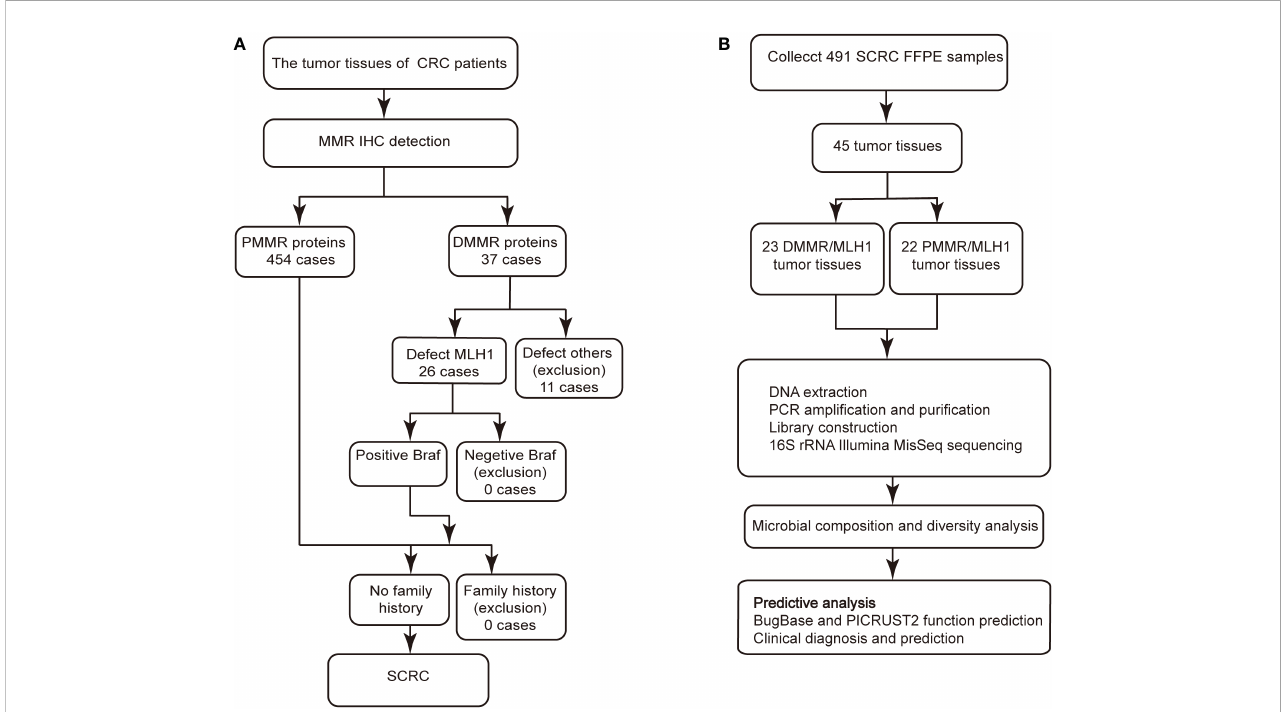
FIGURE 1 IHC staining and Gram staining were performed between the two groups. (A) Screening procedure for SCRC patients by MMR immunohistochemistry. (B) Study design and fl ow diagram. SCRC, sporadic colorectal carcinoma; MMR, mismatch repair; DMMR, de fi cient mismatch repair; PMMR, pro fi cient mismatch